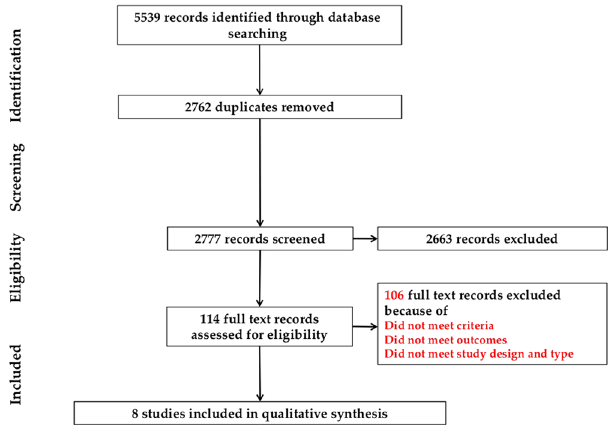
Figure 1. Process of selection of studies has been shown in PRISMA flow